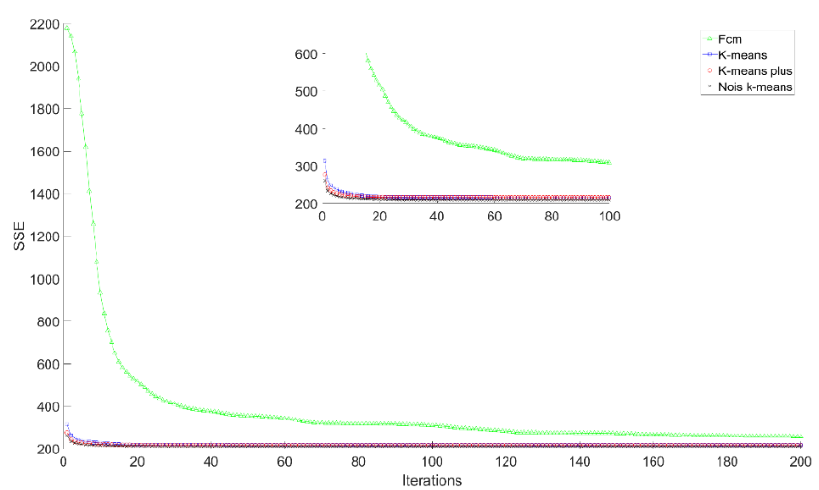
Figure 5. The SSE convergence curve for taxi GPS data (San Francisco (USA)).